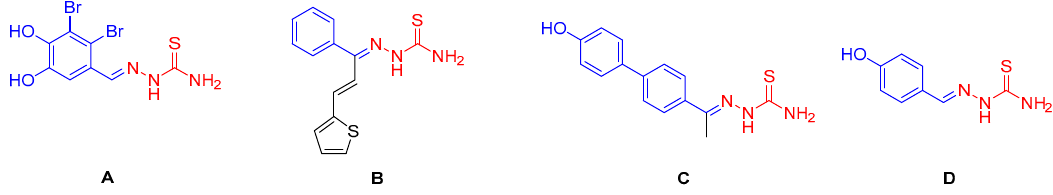
Figure 1. The structure of the benzaldehyde thiosemicarbazide derivatives. ( A ) Anticancer activity; ( B ) antifungal activity; ( C , D ) tyrosinase inhibitor.